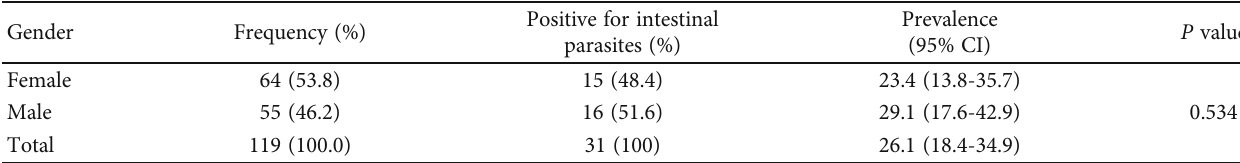
Table 2: Frequency of parasitic infections, based on gender, among intellectually disabled individuals in Bandar Abbas County, Southern Iran.